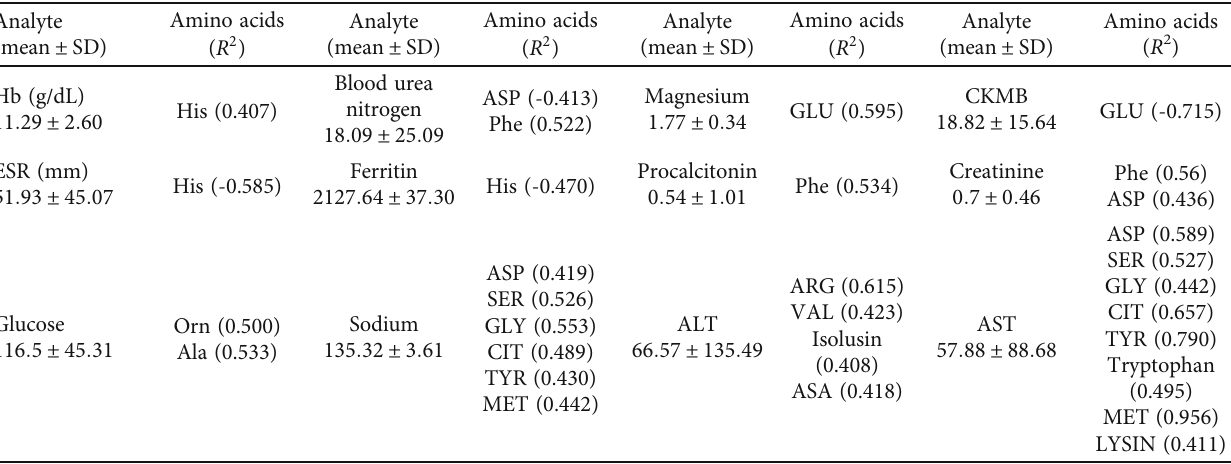
Table 5: The correlation ( R 2 ) between the concentration of free amino acids and biochemical and in fl ammatory factors. ∗ PV < 0 : 05 .